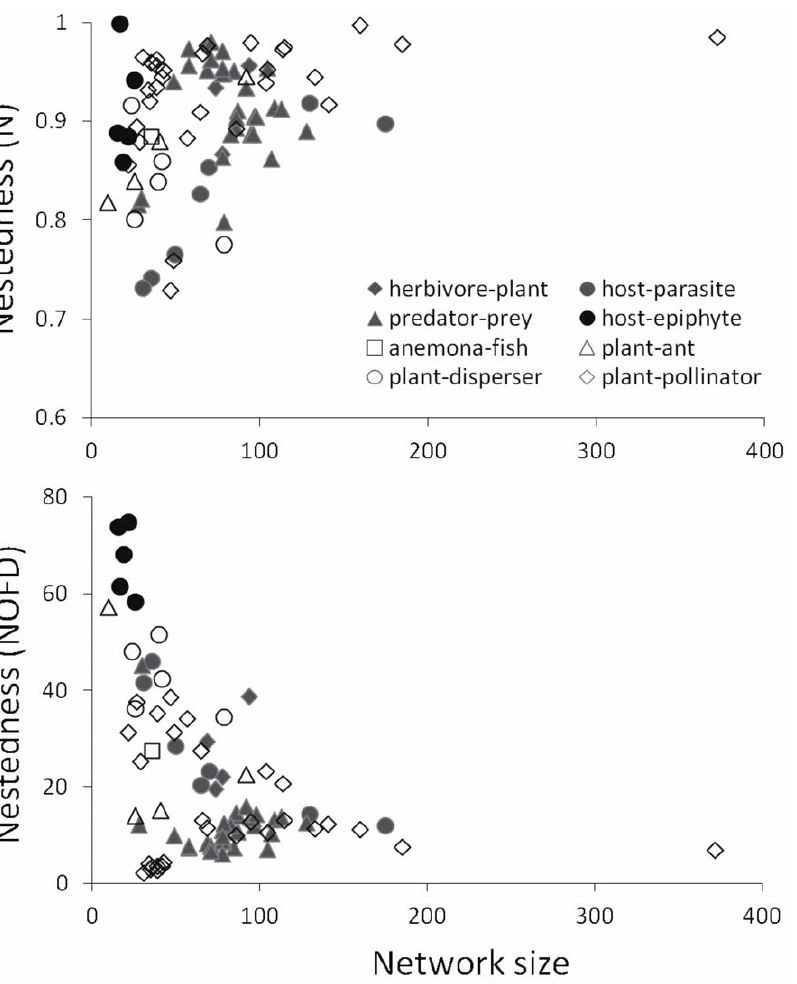
Figure 1. Nestedness of (epiphyte-tree) comensalistic, mutualistic and antagonistic networks. Nestedness is estimated using two different parameters: Atmar & Paterson’s N [38] and Almeida-Neto’s NODF [40]. Insets shows the differences in nestedness between antagonistic, comensalistic and mutualistic networks (after correction for the effect of network size: therefore ‘‘residual N’’ and ‘‘residual NOFD’’).